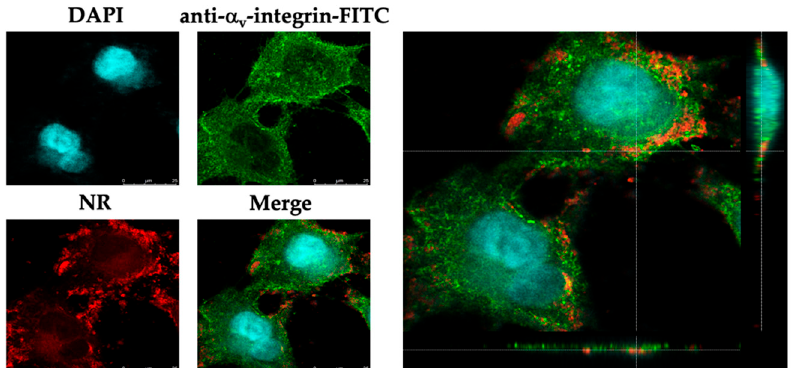
Figure 4. Localization of the EEP-NP-treated cells. XY and orthogonal images demonstrating cellular uptake of the EEP-NPs in the HSV-2-infected Vero cells. The EEP-NPs were traced with NR (red). The nucleus and the cell membrane were indicated using DAPI staining (blue) and a mouse anti- α v - integrin mAb followed by an FITC-conjugated anti-mouse pAb (green), respectively.